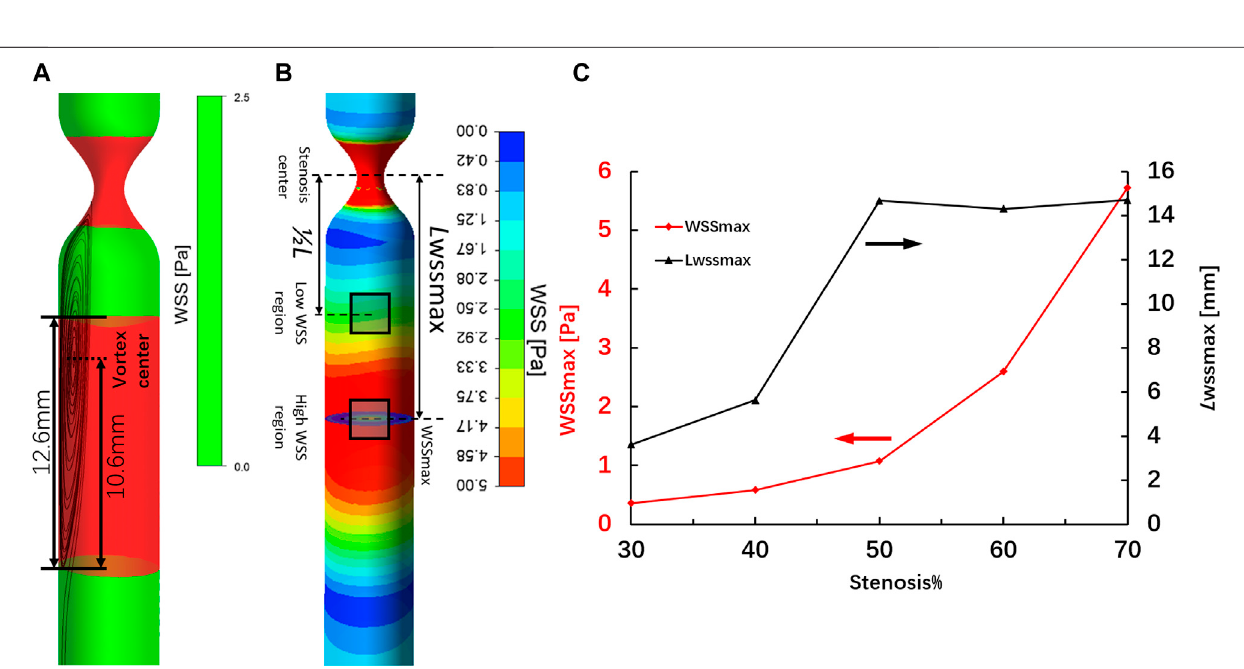
FIGURE5| High-WSSregion (A) andlocationofmaximumWSS (B) intheregiondownstreamofthearterywith70%stenosis.LocationofmaximumWSSandthe value distribution in different stenosed structures (C) .